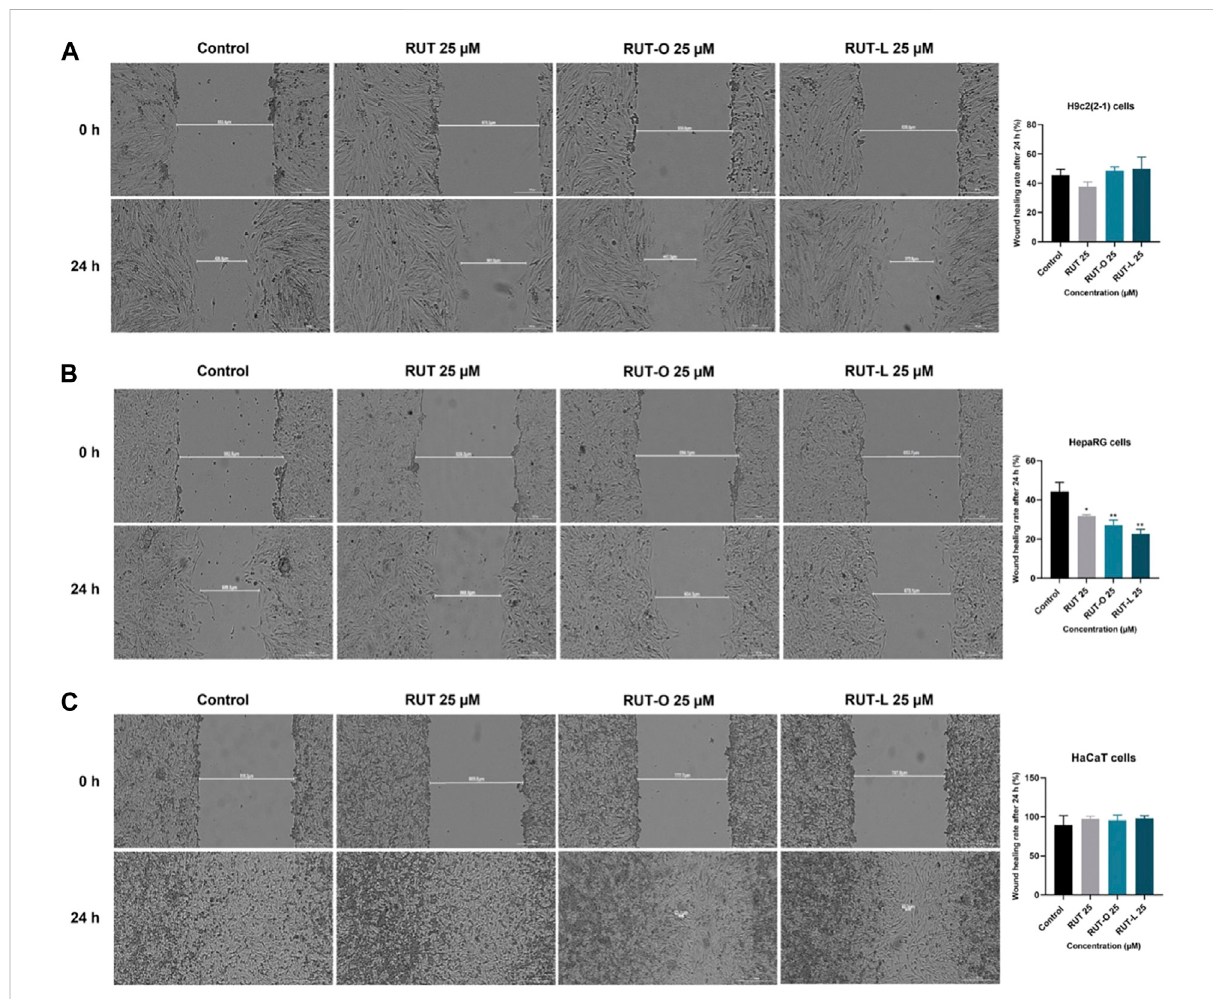
FIGURE 6 Representative images illustrating the impact of RUT, RUT-O and RUT-L 25 µM on wound regeneration in (A) H9c2(2-1) (B) HepaRG and (C) HaCaT cells following a 24 h treatment and graphic representations of the calculated wound healing rates. The scale bars represent 300 µm. The dataareexpressedasmeanvalues±SDofthreeindependentexperimentsperformedintriplicate.Thestatisticaldifferencesbetweenthecontroland thetreatedgroupwerequanti fi edbyapplyingtheone-wayANOVAanalysisfollowedbytheDunett ’ smultiplecomparisonspost-test(* p < 0.05; ** p <